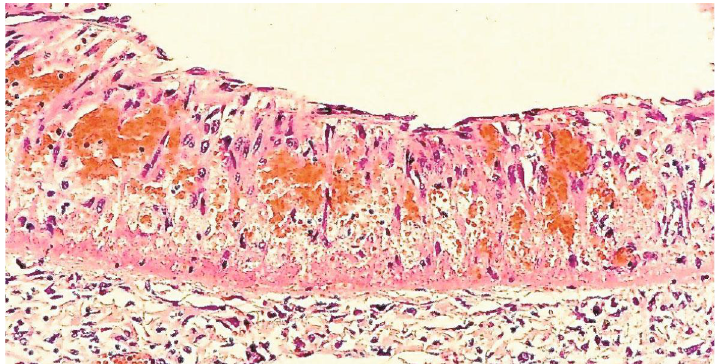
Figure 5: Segmental arterial mediolysis injurious phase. The artery show areas of mediolysis ranging in sites from the outer half to the transmural involvement of the media. Mediolytic foci contain cytoplasmic and membranous debris, scattered viable muscle cells, newly forming capillaries, and red cells. A thick linear layer of fi brin coats the adventitia. The intima is preserved. Hematoxylin & eosin × 200.